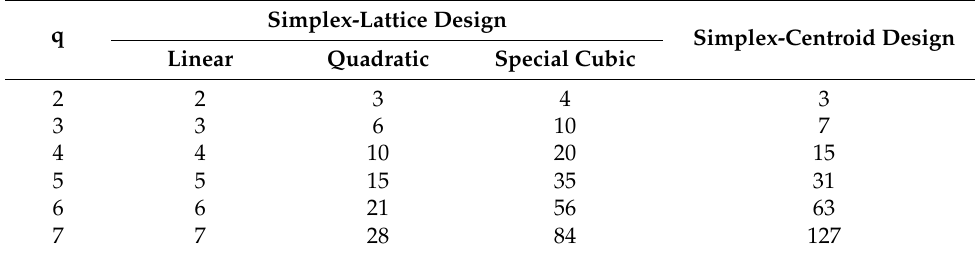
Table 2. Number of experiments for simplex-lattice and simplex-centroid designs according to the number of components (q) and the postulated models. Simplex-Lattice Design q